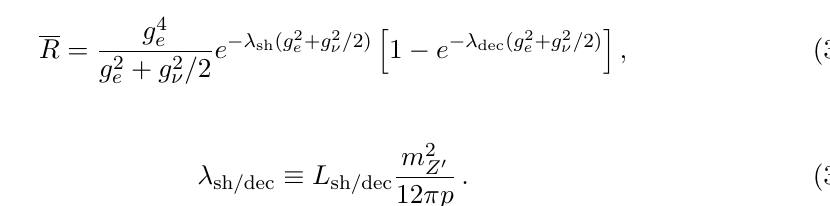
) = 10 − 19 , demonstrating Z 0 , g e and g Z 0 e